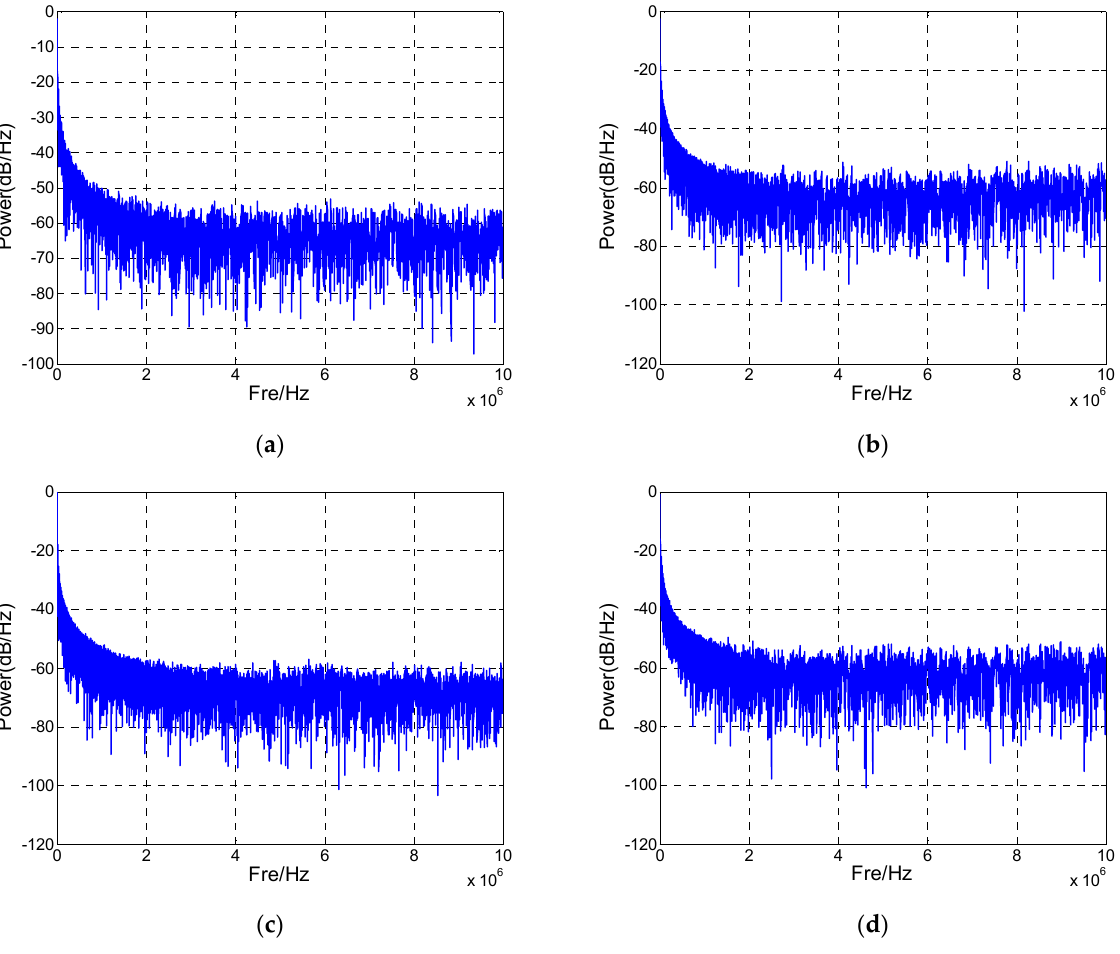
Figure 4. PSD of autonomous EDM process for pulse-on-time = 48 μ s, p-ratio = 6, power-amplifier = 3. ( a ) Unstable sparkdischarge; ( b ) stable spark discharge; ( c ) stable arc discharge; ( d ) transient arc discharge.